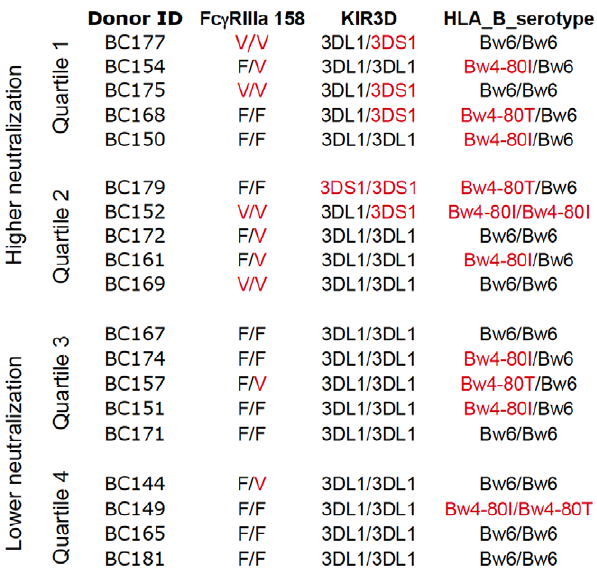
Figure 4. Donor PBMC ranked by neutralization. PBMC from 19 donors were used as target cells for neutralization using 6 virus stocks and 7 neutralization reagents. The ranking and separation of donors into the upper two quartiles (‘‘High neutralization’’) and the lower two quartiles (‘‘Low neutralization’’) is indicated, along with the genotypes for KIR3D, HLA-B_80, and Fc c RIIIa 158. Red text indicates 3DS1 + , Valine (V) at Fc c RIIIa position 158, or licensing through HLA-B with Bw4-80I or